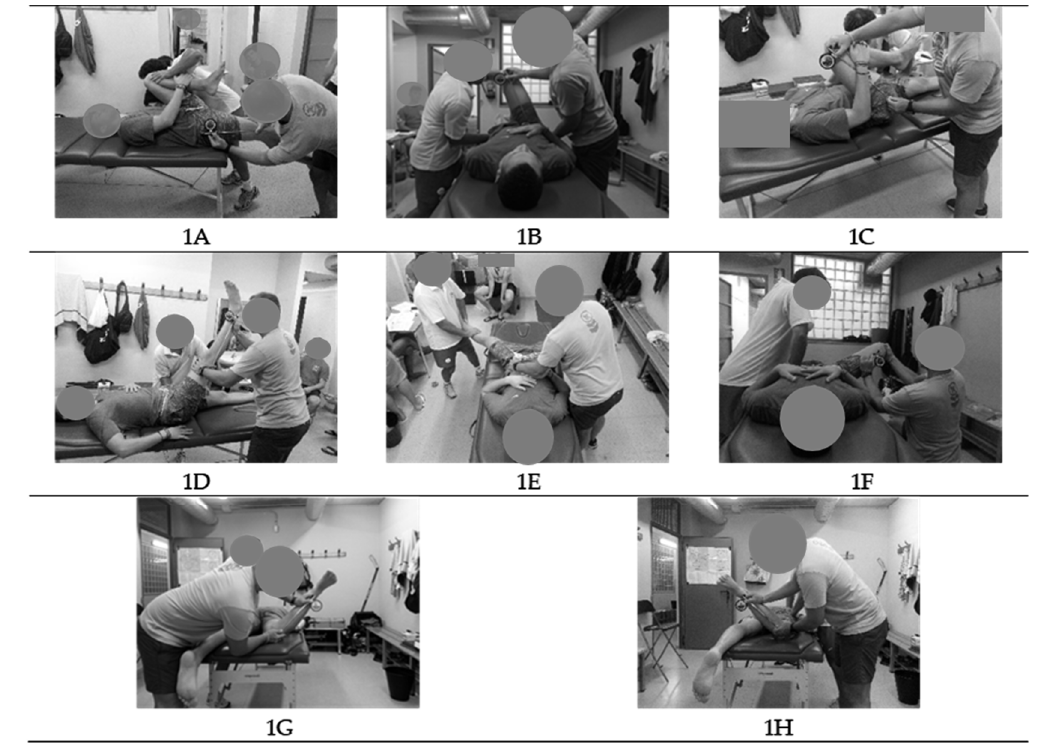
Figure 1. Lower extremity hip ranges of motion of the ROM-Sport Battery: Hip extension test [HE] ( A ), hip adduction with hip flexed 90° test [HAD-HF] ( B ), hip flexion with knee flexed test [HF-KF] ( C ), hip flexion with knee extended test [HF-KE] ( D ), hip abduction with hip neutral test [HAB] ( E ), hip abduction with hip flexed 90° test [HAB-HF] ( F ), hip internal rotation test [HIR] ( G ), hip external rotation test [HER] ( H ); ROM: range of motion.